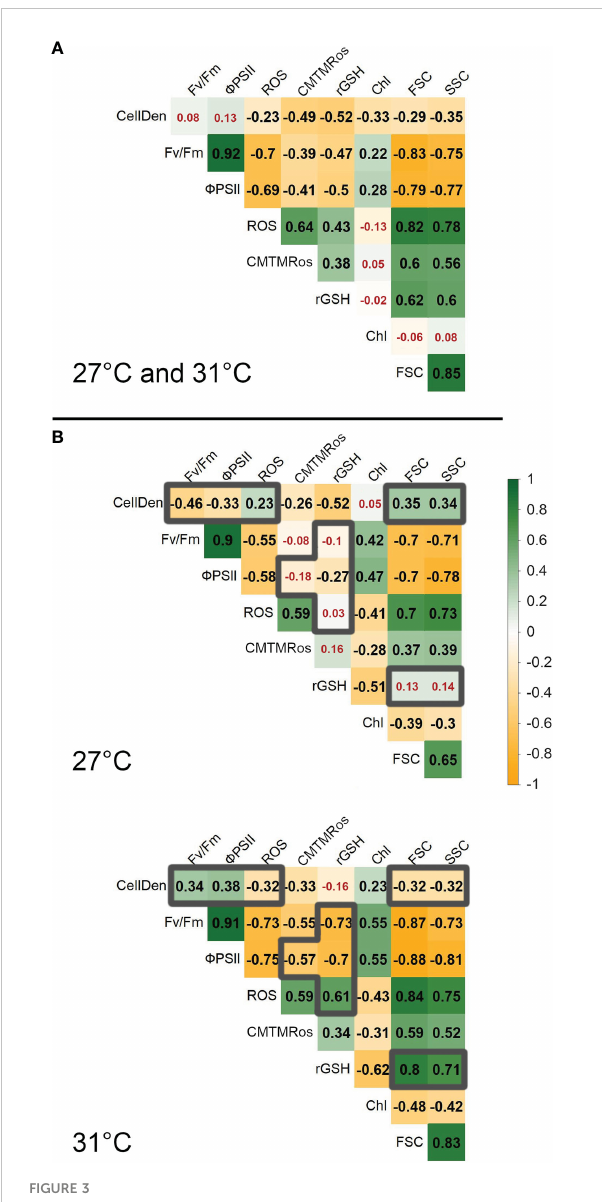
FIGURE 3 Pairwise Pearson correlation coef fi cients (r) between parameters. (A) shows the results for all data, combining 27°C and 31°C. (B) shows the results for each temperature separately. To highlight major differences between the two temperatures, grey borders are used to mark r values that differ between 27°C and 31°C by ≥ 0.5. In order to facilitate visualization of large vs small correlations in each panel, red numbers are used to indicate r values< 0.2. CellD, cell densities; F v /F m , maximum quantum ef fi ciency; f PSII, PSII operating ef fi ciency; ROS, reactive oxygen species measured with CellROX Orange; CMTMRos, mitochondrial activity measured using MitoTracker Orange; rGSH, reduced glutathione measured with VitaBright-48; Chl, pigment content of cells; FSC, forward scatter; SSC, side